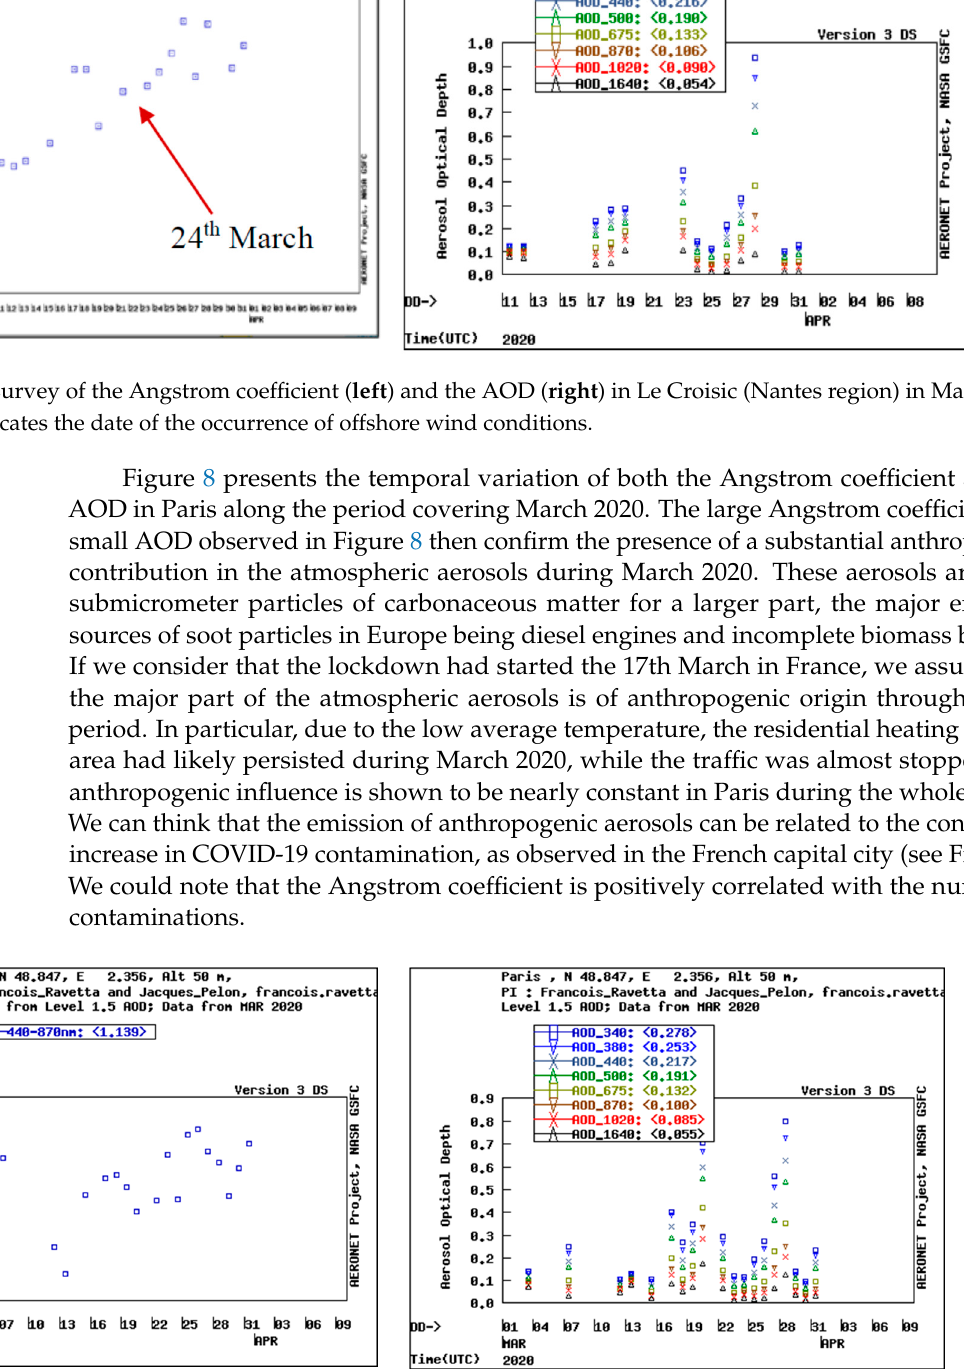
Figure 8. Temporal survey of the Angstrom coefficient ( left ) and the AOD ( right ) in Paris in March 2020.